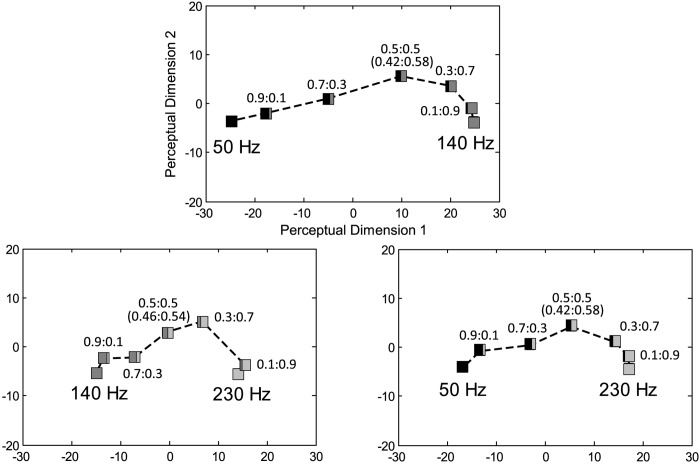
Perceptual spaces obtained from the dissimilarities measured in Experiment I.Amplitude mixture ratios in acceleration are represented in parentheses.